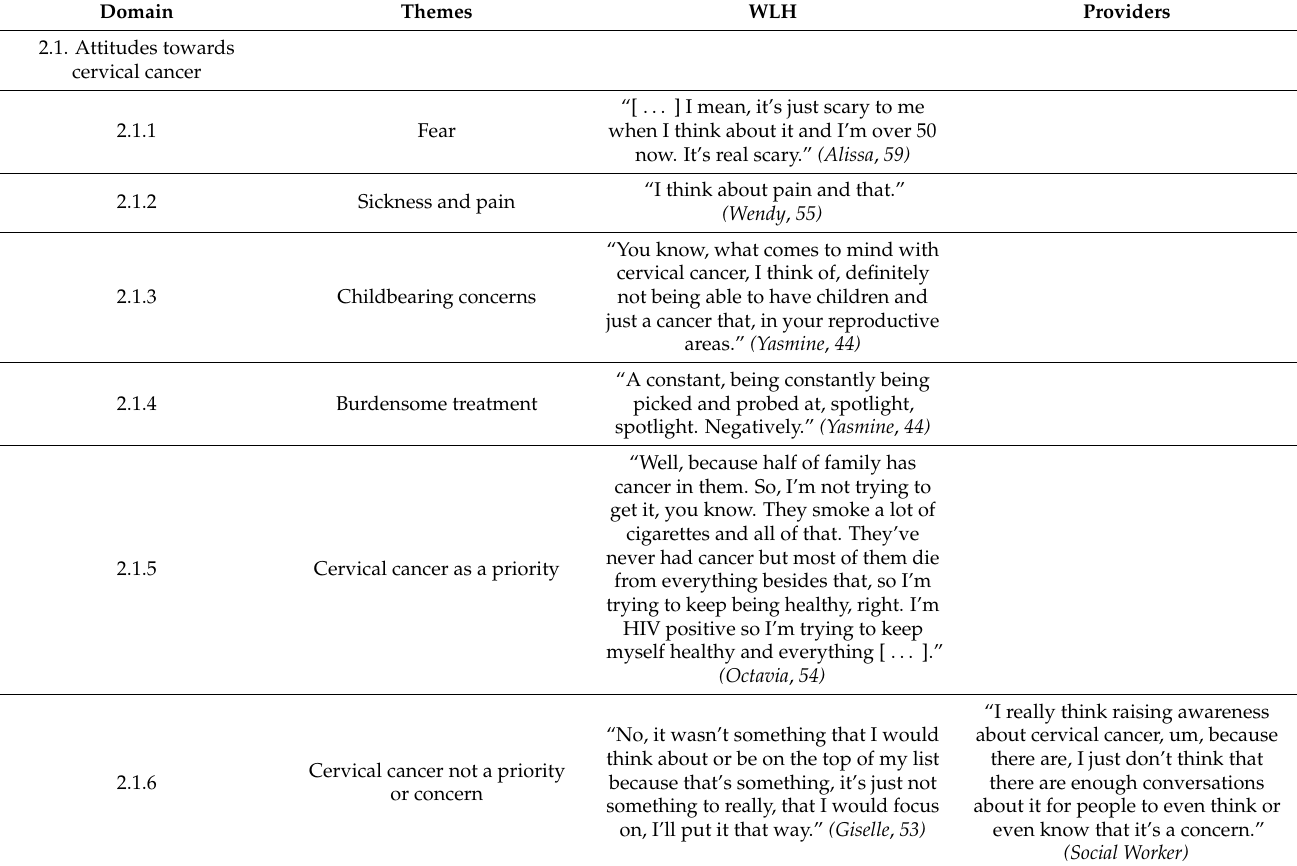
Table A2. Domain and themes from providers and women living with